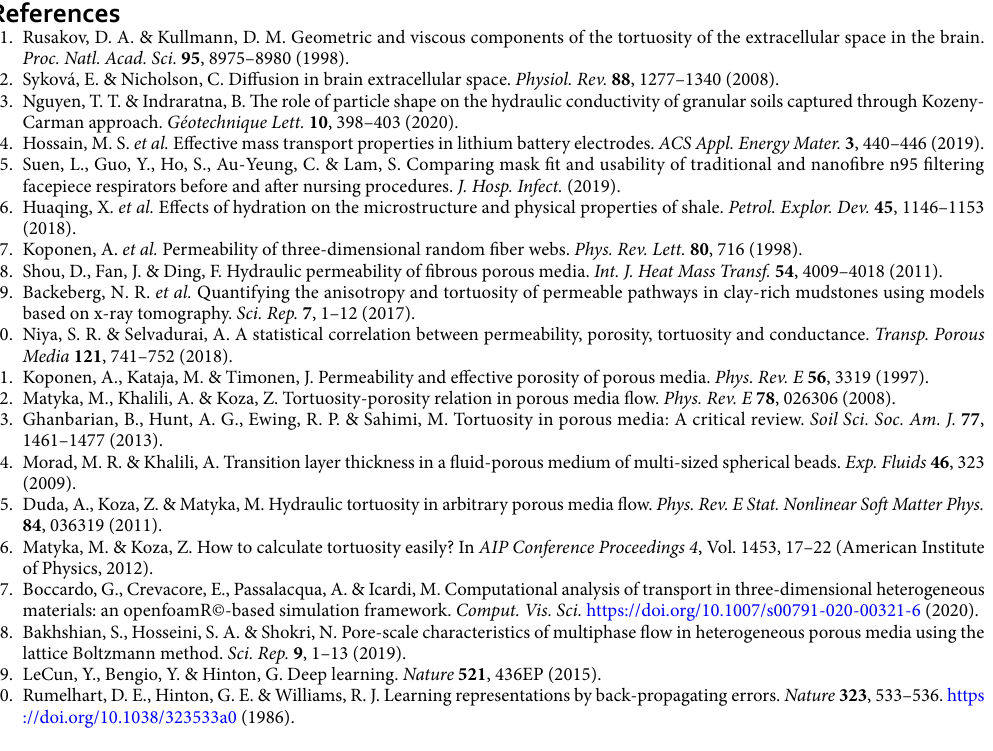
Figure 9. Tortuosity versus porosity: solid line represents empirical relation T (ϕ) within classical fluid flow approach 12 . The points are obtained from the unlabelled data